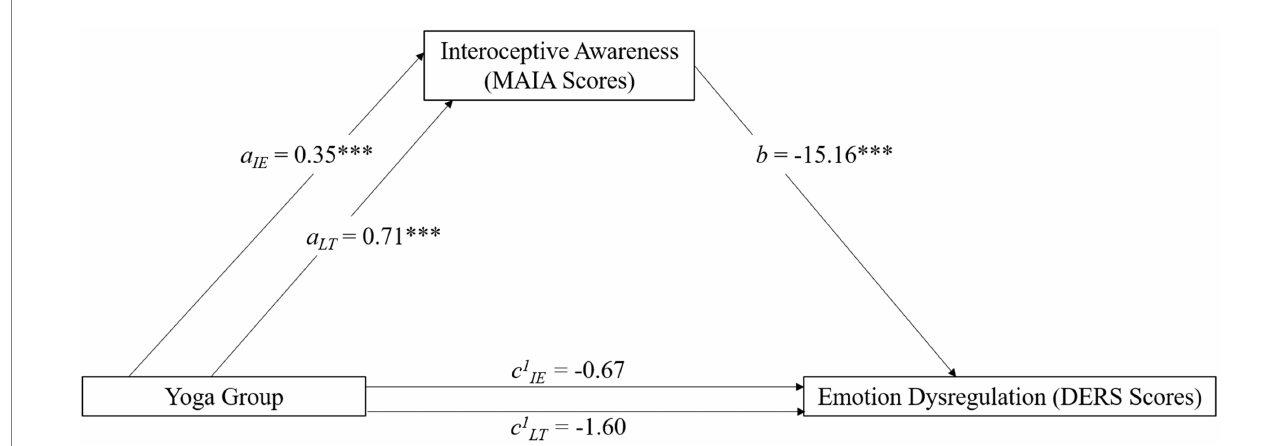
FIGURE 2 Mediation model featuring yoga practice (predictor), emotion dysregulation (outcome), and interoceptive awareness (mediator). Variables with subscript IE represent a comparison between the no experience and intermittent experience (IE) group. Subscript LT represents a comparison between the no experience and the long-term (LT) group. This model demonstrates that the relationship between intermittent and long-term yoga practice and emotion dysregulation is mediated by interoceptive awareness. *** denotes significance with p < 0.001. No asterisk represents a non-significant finding.